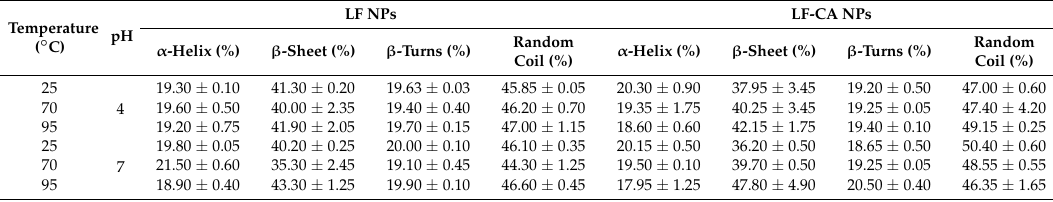
Table 5. Secondary structure elements of LF and LF in LF-CA NPs formed at different conditions.